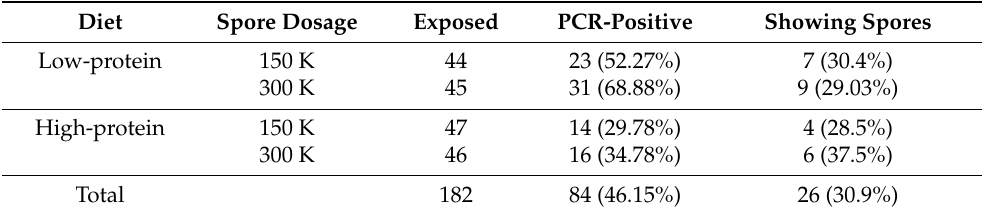
Table 2. Number of bumblebees exposed to N. ceranae that were PCR-positive and showed spores in their gut. The percentage of PCR-positive bumblebees relative to all exposed bumblebees and the percentage of bumblebees showing spores in their gut relative to all PCR-positive individuals are given in brackets. Diet Spore Dosage Exposed PCR-Positive Showing Spores Low-protein 150 K 44 23